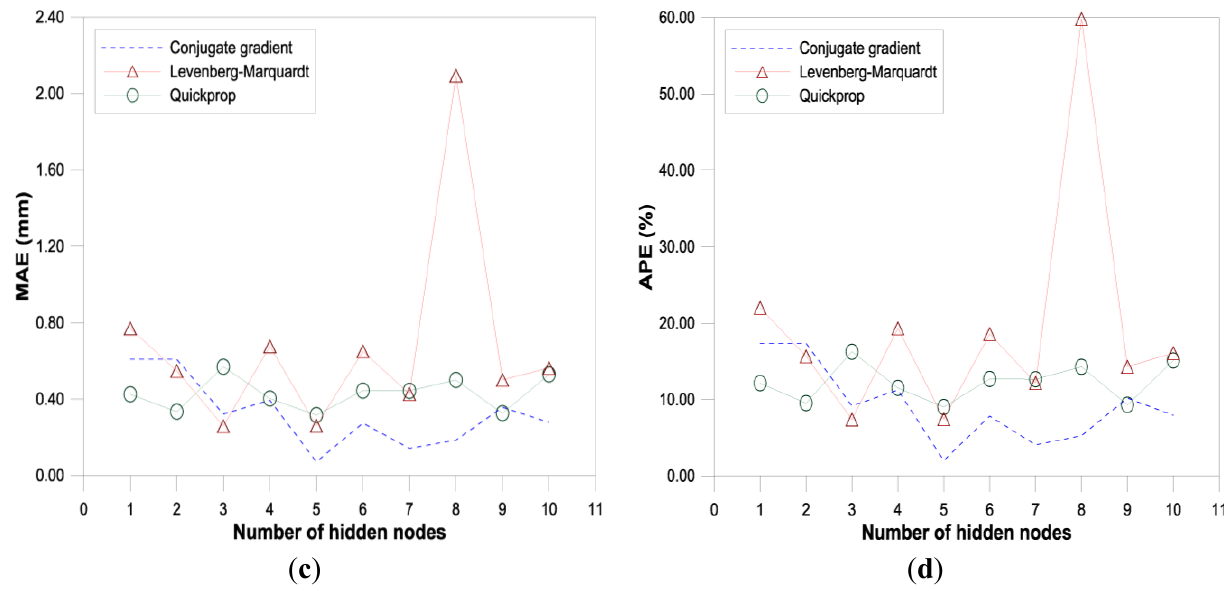
Figure 2. Influence of the number of hidden nodes for three training algorithms (test period).